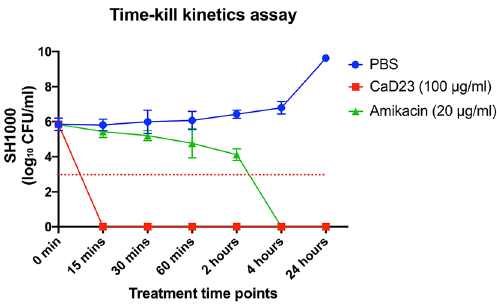
Figure 4. Time-kill kinetics of CaD23 (4× MIC) and amikacin (8× MIC) against S. aureus (SH1000) in cation- adjusted Muller-Hinton broth and physiological tear salt concentration (150 mM NaCl) over 24 h. Phosphate buffer solution (PBS) group serves as the untreated control. “0 min” represents the starting inoculum, which is around 6 log 10 CFU/ml. The red dotted horizontal line at ~ 3 log 10 CFU/ml signifies the threshold of significant bacterial killing (defined as 99.9% or 3 log 10 CFU/ml reduction of the bacterial viability compared to the starting inoculum). Data is presented as mean ± standard deviation (depicted in error bars) of two independent experiments performed in biological duplicate. CaD23 (4× MIC) was able to achieve complete (100%) killing of SH1000 within 15 min of treatment whereas amikacin (8× MIC) was only able to achieve complete killing of SH1000 within 4 h of treatment. The antimicrobial efficacy of CaD23 and amikacin was maintained at 24 h post-treatment.